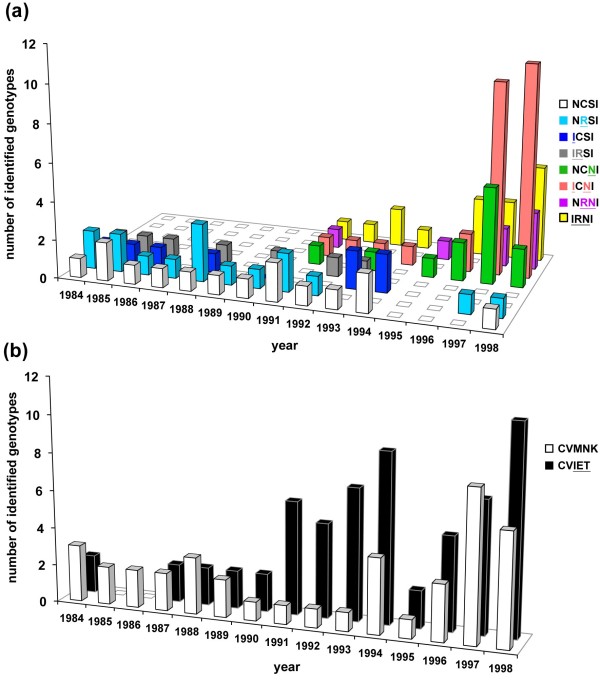
Yearly change in the number of dhfr- and pfcrt-genotypes in Africa between 1984 and 1998. (a) Wild-type (NCSI), pyrimethamine-sensitive (NRSI, ICSI, IRSI) and pyrimethamine-resistant (NCNI, ICNI, NRNI, IRNI) dhfr genotypes were identified in blood samples collected from cases of Plasmodium falciparum malaria in Africa between 1984 and 1998. The height of each coloured bar shows the number of samples in that year infected with that particular genotype. (b) Wild-type (CVMNK; white bars) and chloroquine-resistant (CVIET; black bars) pfcrt genotypes were identified in blood samples collected as above. The height of each bar shows the number of samples in that year infected with that genotype.